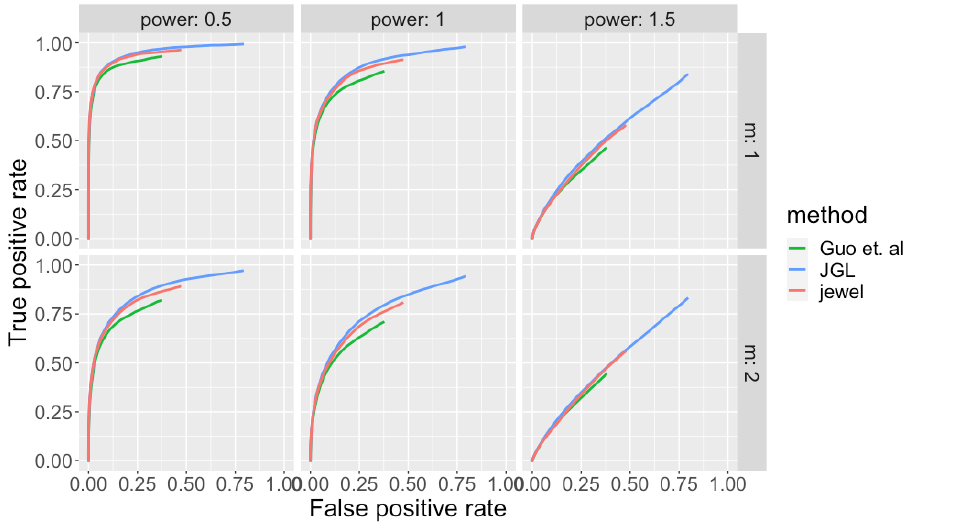
Figure 5. ROC-curve for different joint estimation methods: jewel , JGL [14] and Guo et al. proposal [13] for K = 3, p = 500, n k = 100 ∀ k . Each panel demonstrates performance in differ- ent m − power